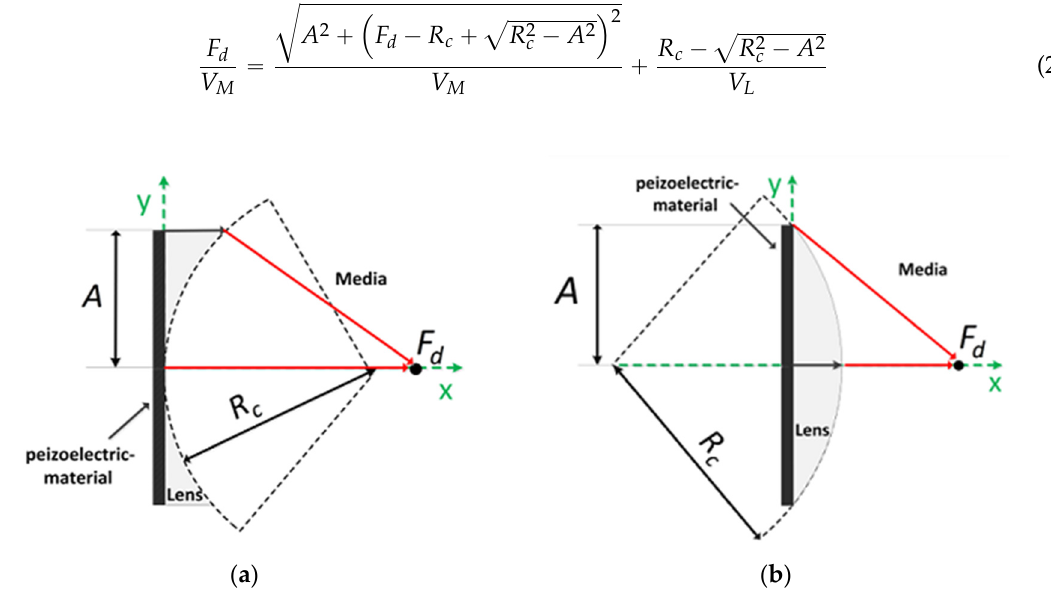
Figure 1. Conventional lens configuration and design parameters: ( a ) concave and ( b ) convex lenses.